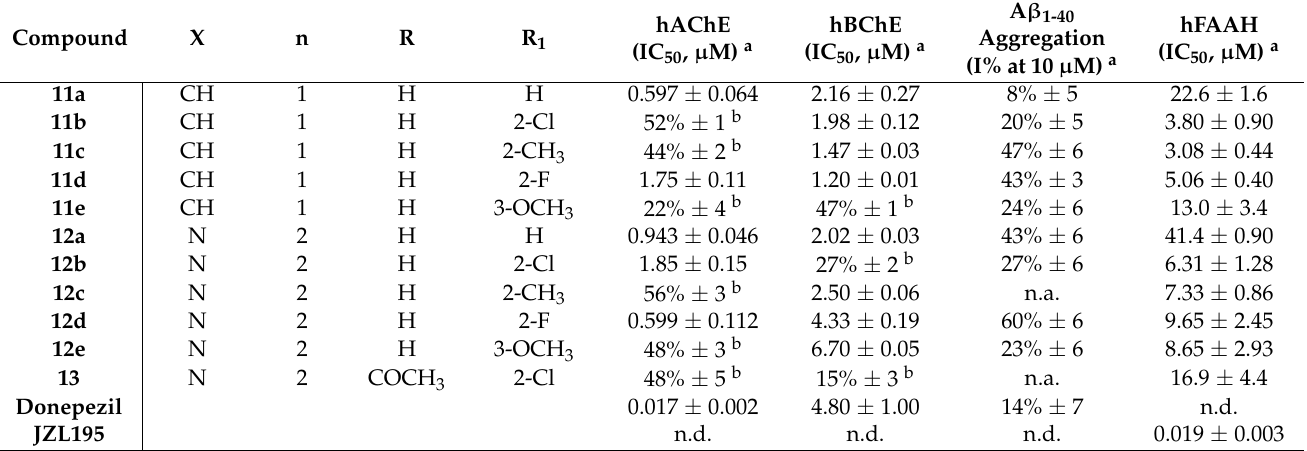
Table 1. Biological activities of compounds 11a–e , 12a–e and 13 towards AChE, BChE, A β 1-40 aggregation and